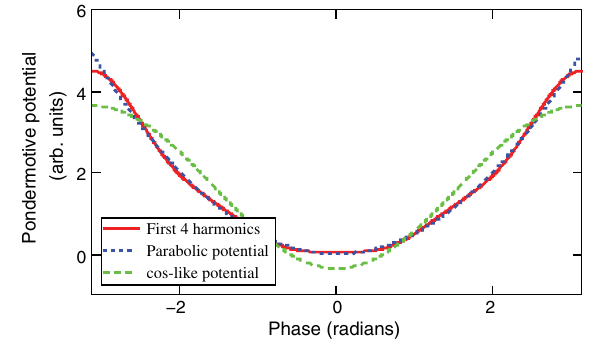
FIG. 5. Ponderomotive pendulum like potential. Harmonic os- cillator potential and approximation with first 4 harmonics.